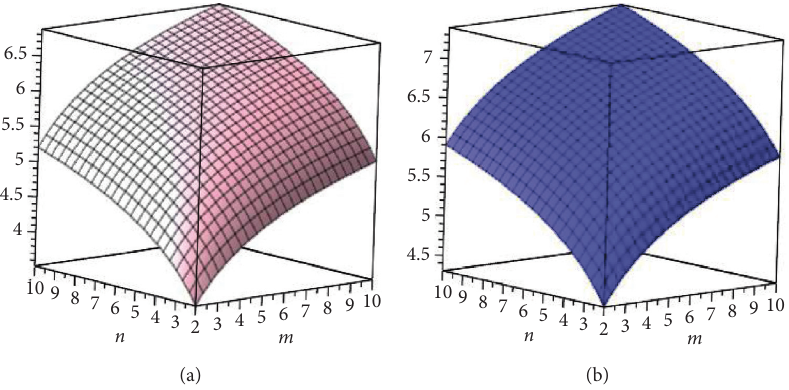
Figure 15: (a) The atom bond connectivity entropy; (b) the geometric arithmetic entropy.